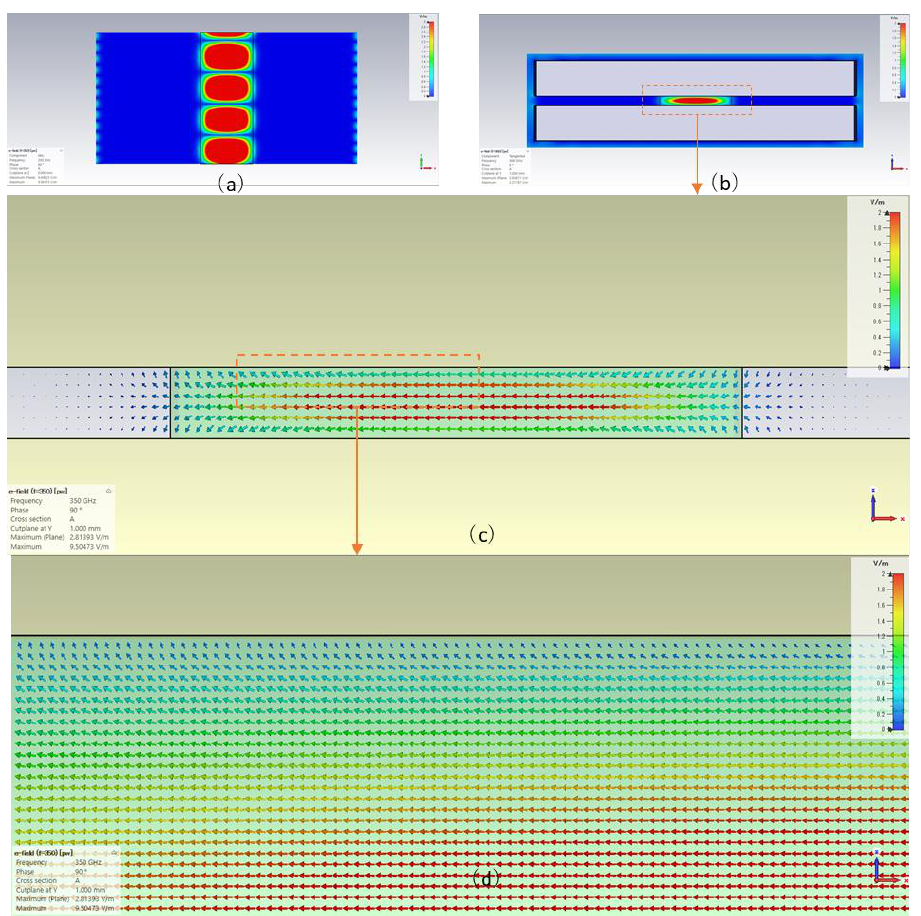
Figure 2. Simulation results of basic NRD waveguide at 350 GHz ( a ) z = 0 plane, ( b ) y = 1 plane, and ( c ) and ( d ) enlarged view of y = 1 plane.